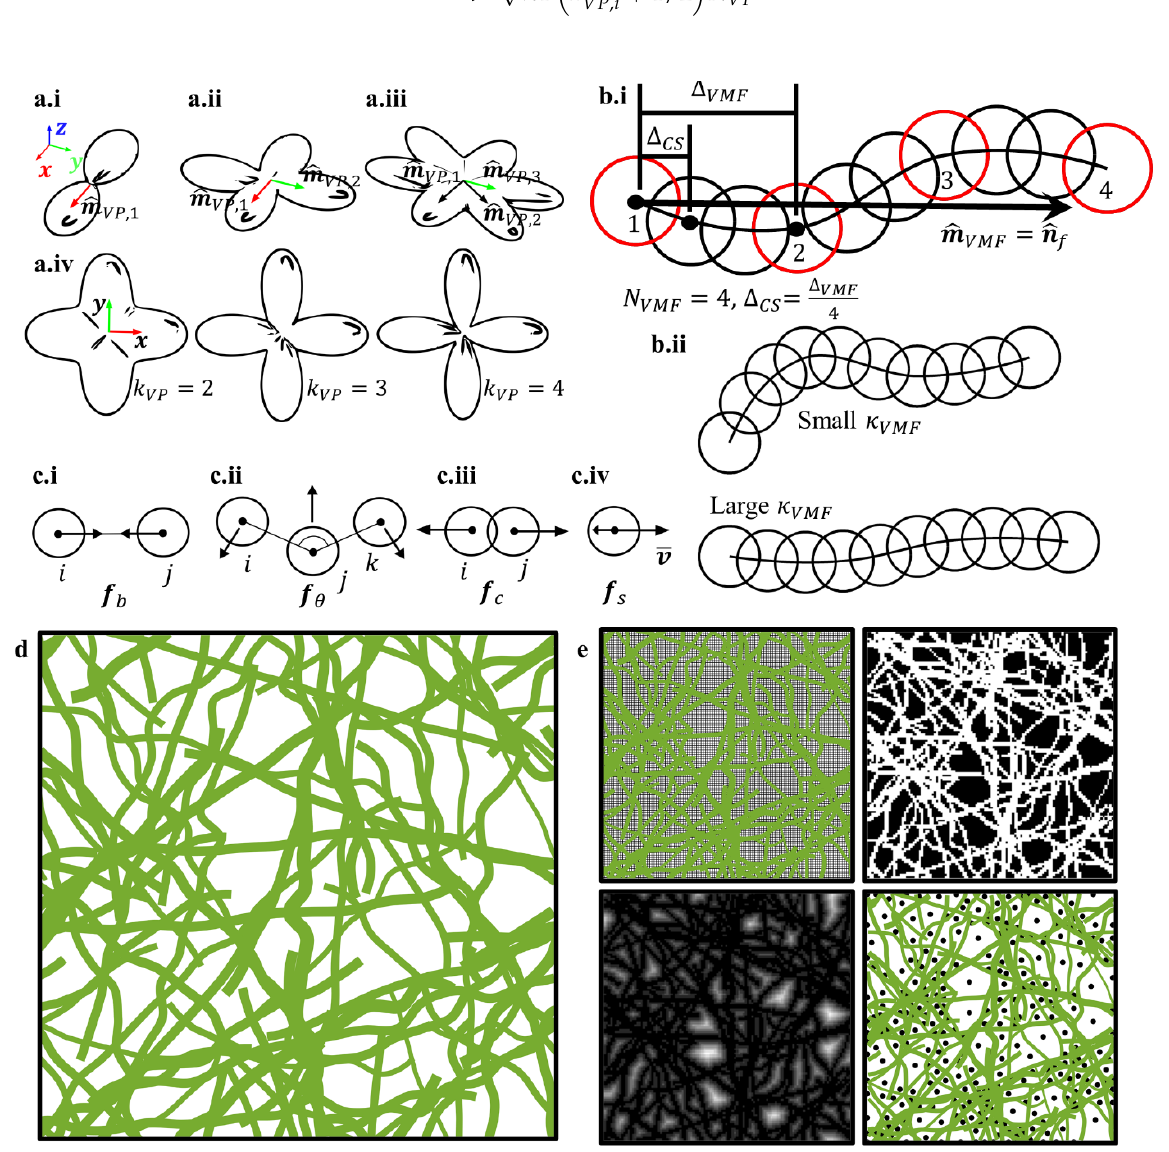
Figure 1. ( a.i – a.iv ) Schematic of the de la Vallee Poussin distribution for ( a . i ) transverse